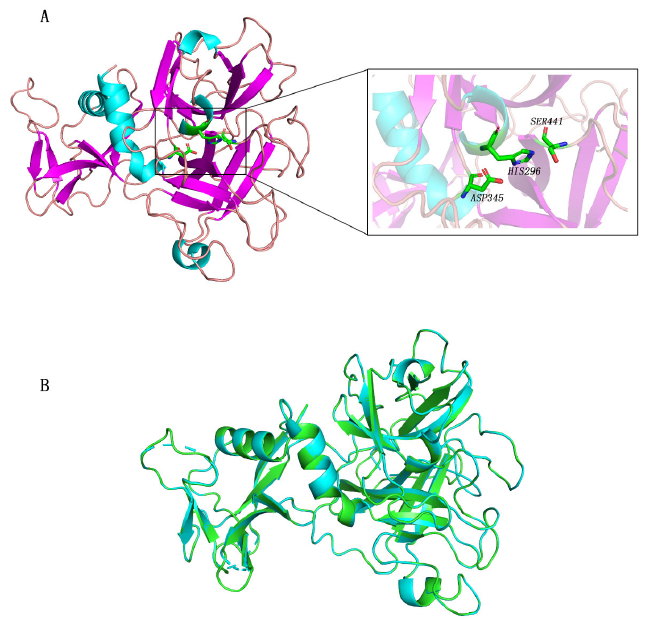
Figure 1. Structure of TMPRSS2 (PDB ID 7MEQ). Active site residues His296, Asp345, and Ser441 are presented as green sticks ( A ). Alignment diagram between 7MEQ and reconstructed TMPRSS2; RMSD is 0.049 Å ( B ). TMPRSS2 is presented in green; 7MEQ is presented in blue.